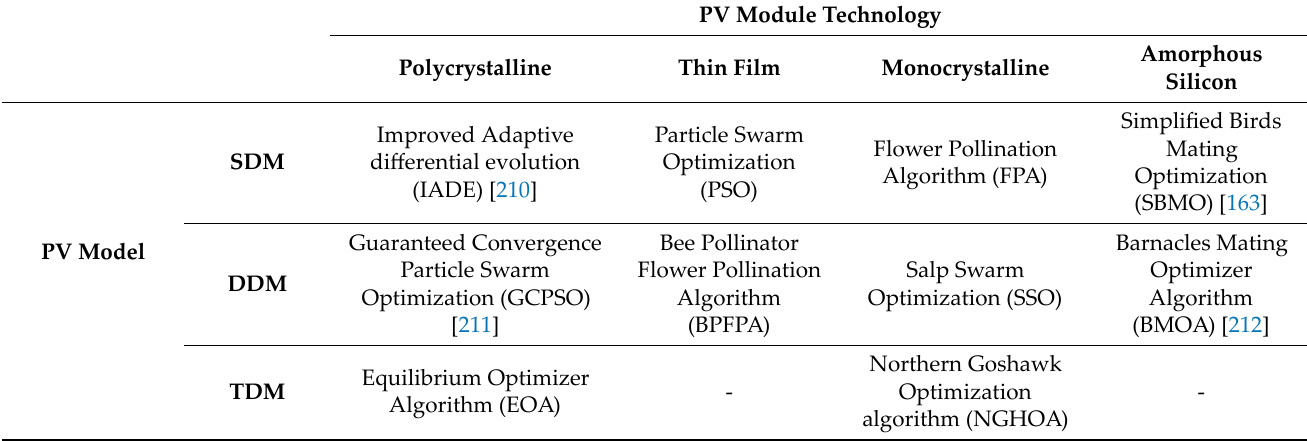
Table 10. Selection of metaheuristic algorithm vs. PV module technology and PV